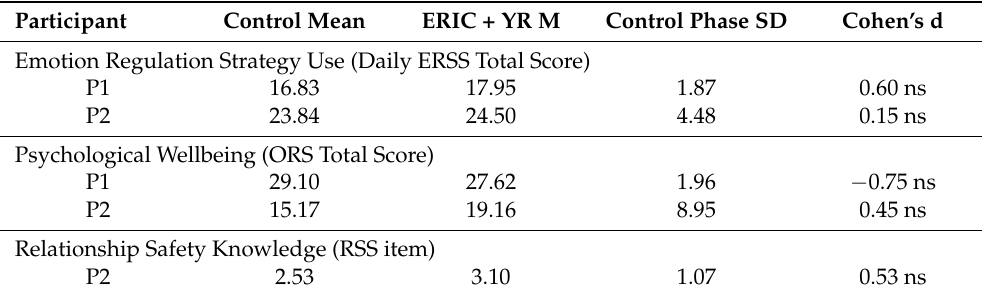
Table 4. Descriptive statistics, p -values and effect sizes for outcomes (daily measures).